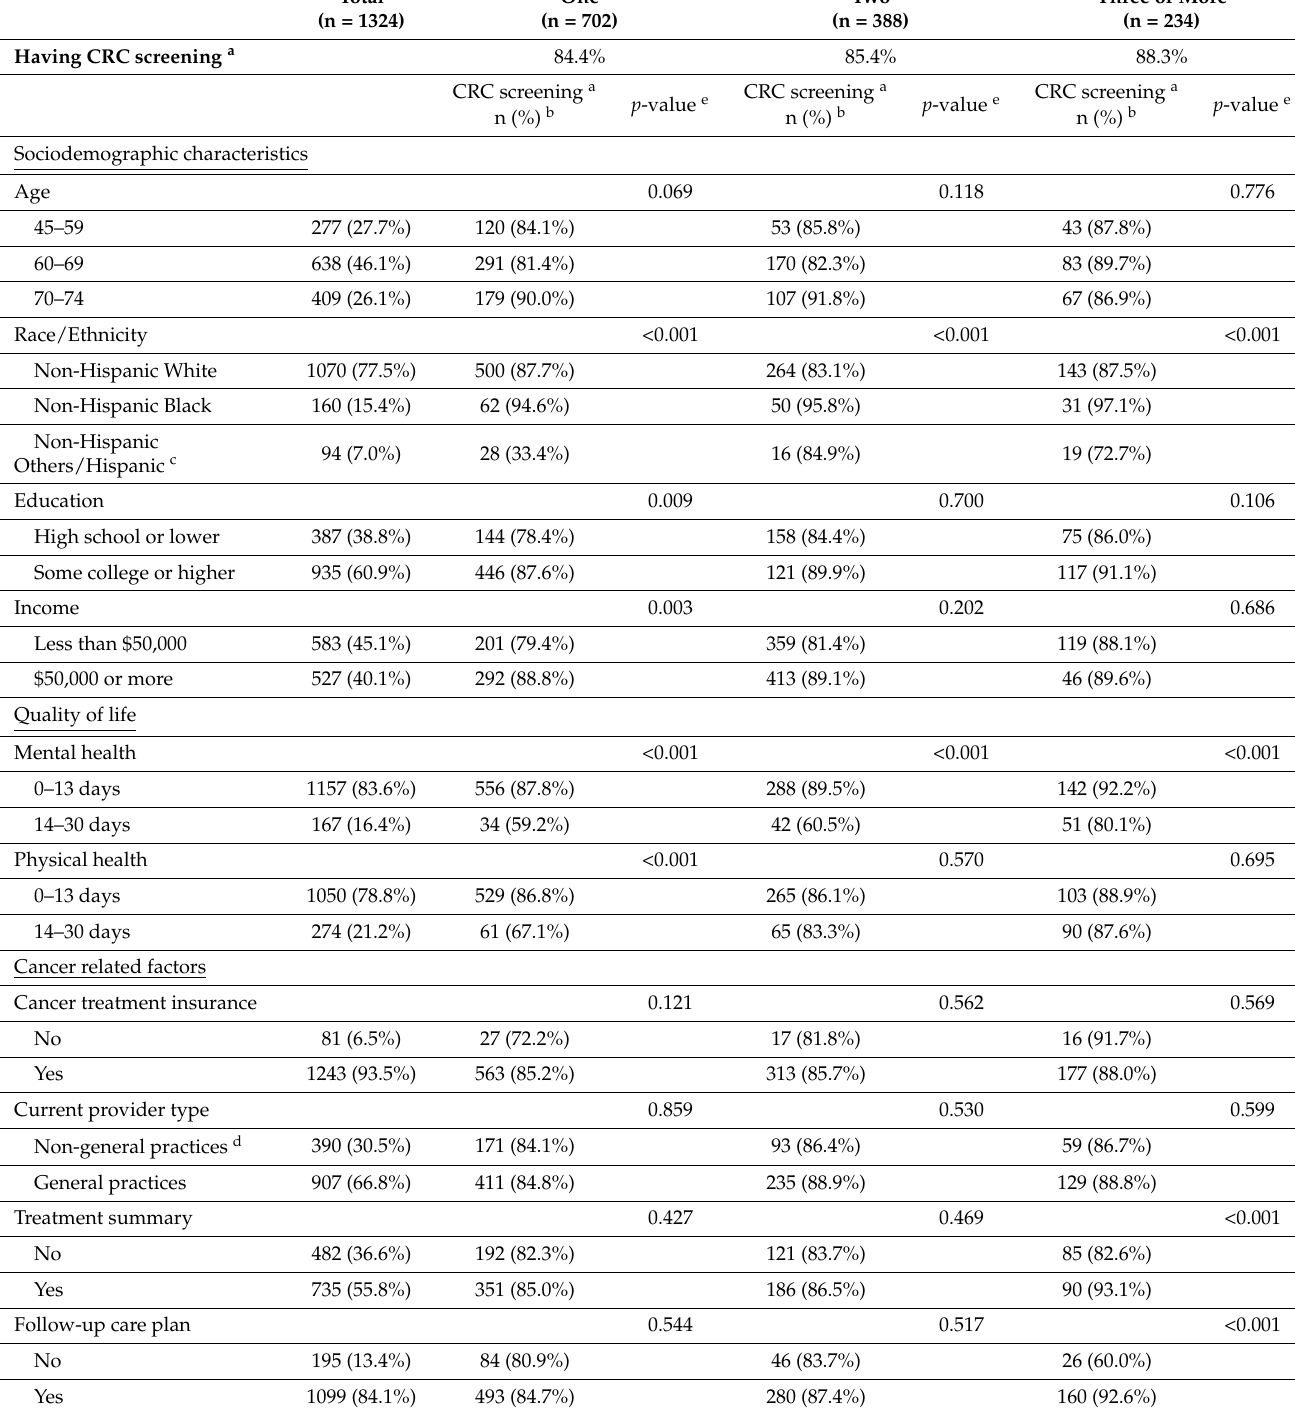
Table 1. Descriptive statistics of sociodemographic characteristics, quality of life, cancer related factors, and CRC screening utilization (outcome of interest) by chronic disease conditions.